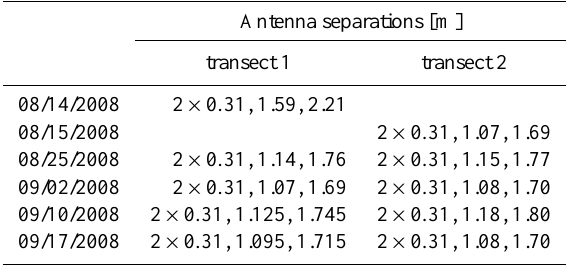
Table 1. Antenna separations of the four channels used in the radar surveys (determined before and after each survey). Measurement accuracy